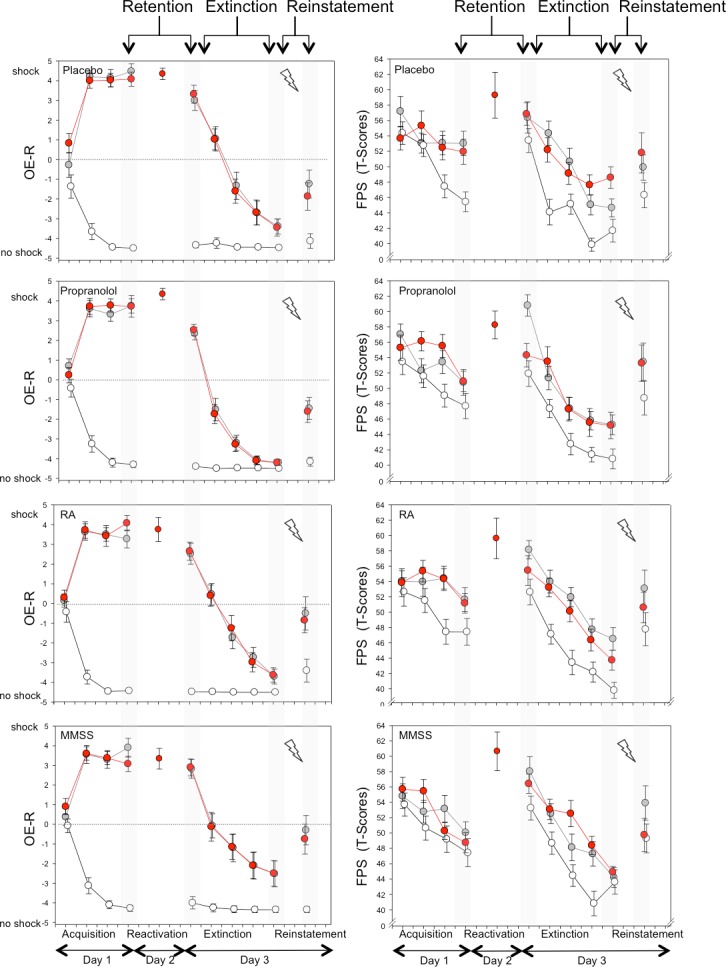
US online expectancy ratings and fear potentialed startle during acquisition, reactivation, and reinstatement testing.US online expectancy ratings (OE-R, left column) and fear potentiated startle (FPS, right column) for the four intervention conditions (placebo, propranolol, cognitive reappraisal (RA), multisensory stimulation (MMSS)) and the three types of stimuli (white circles: CS-, red circles: reactivated CS+, grey circles: non reactivated CS+) for the different phases of the experimental procedure (please note, data corresponds to averages across two consecutive trials, except for reinstatement, which displays the first trial after reinstatement)